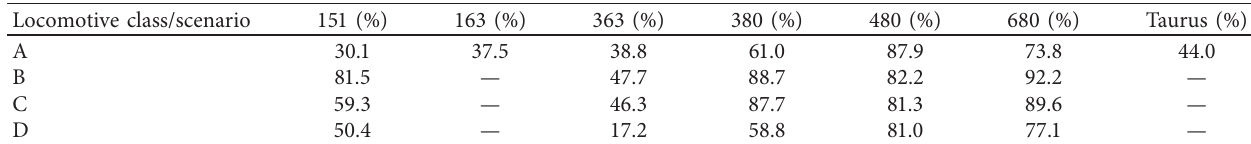
Figure 9: Confusion matrix for the best performing CNN for scenario Table 7: Mean accuracy for different locomotive classes.